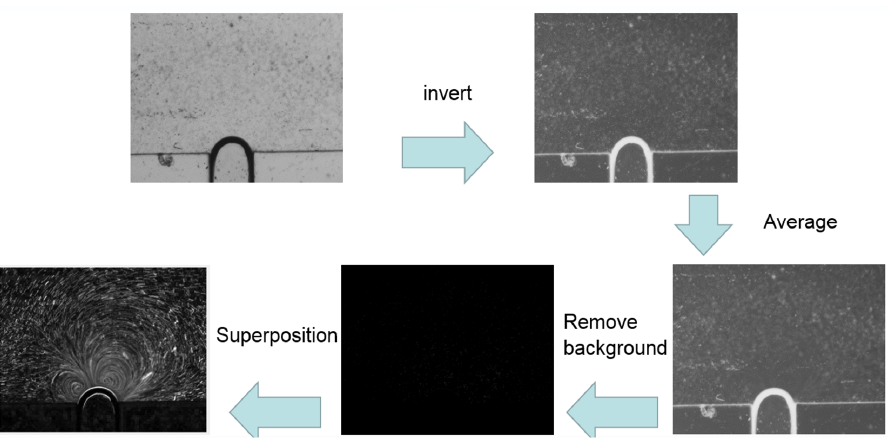
Figure 4. Process flow of image pre-processing to invert the image and remove background.